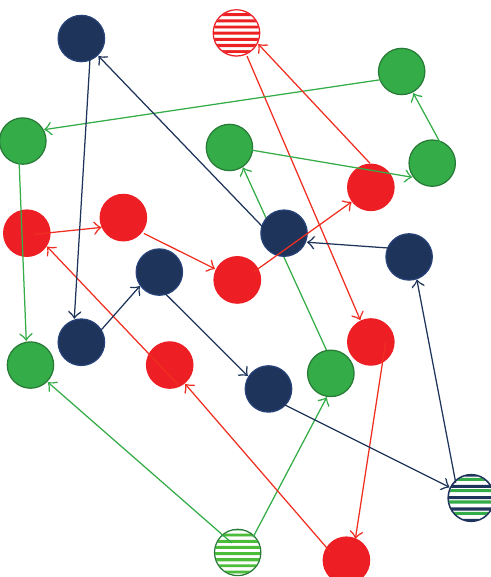
Figure 2: Results of ASClass algorithm on graph used in Figure 1: tree clusters are drawn; each of them is created by a colony of ants in the ASClass